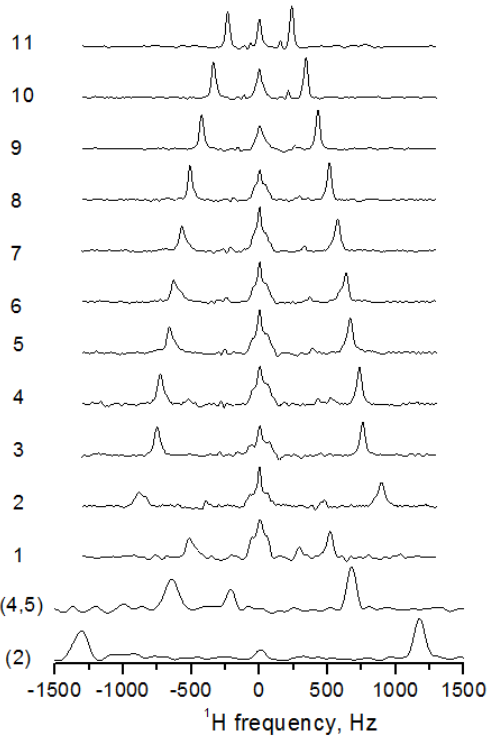
Figure 3. Dipolar cross section along 1 H dimension from the two-dimensional (2D) 13 C- 1 H PDLF spectrum of C 12 C 12 imBr in smectic A phase at 97 ◦ C. The spectra of the imidazolium carbons, C(2) and C(4,5), were recorded in a separate experiment with a larger spectral width in the proton dimension and with a decoupling frequency optimized for imidazolium protons.